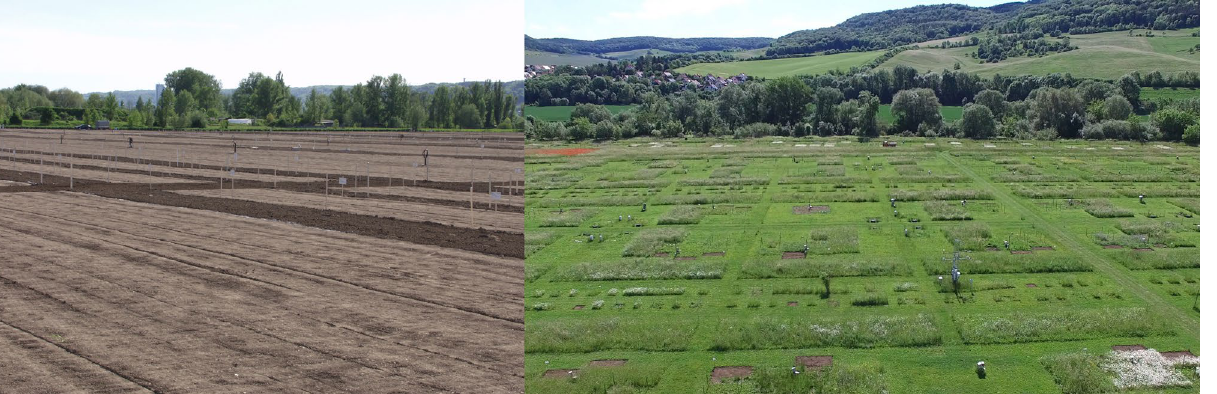
Figure 1. The 10-ha site was used as arable land until 2000, and was converted to an experimental grassland in 2002. For this, the area was completely tilled and experimental plots of different plant diversity were sown, separated from each other by paths (left photo: field site in 2002; right photo: field site in 2016). The plant community composition of each plot was randomly selected out of a species pool of 60 grassland species. Each diversity level is replicated 16 times, except for 16 and 60-species mixtures, which have 14 and 4 replicates, respectively. After the plots became established, colonization by above- and belowground fauna began. Left photo by K. Kübler, copyright of right photo by the Jena